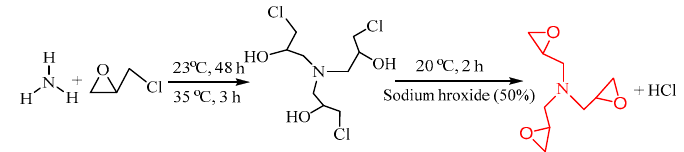
Figure 1. The synthesis procedure of cross-linker triglycidylamine (TGA).